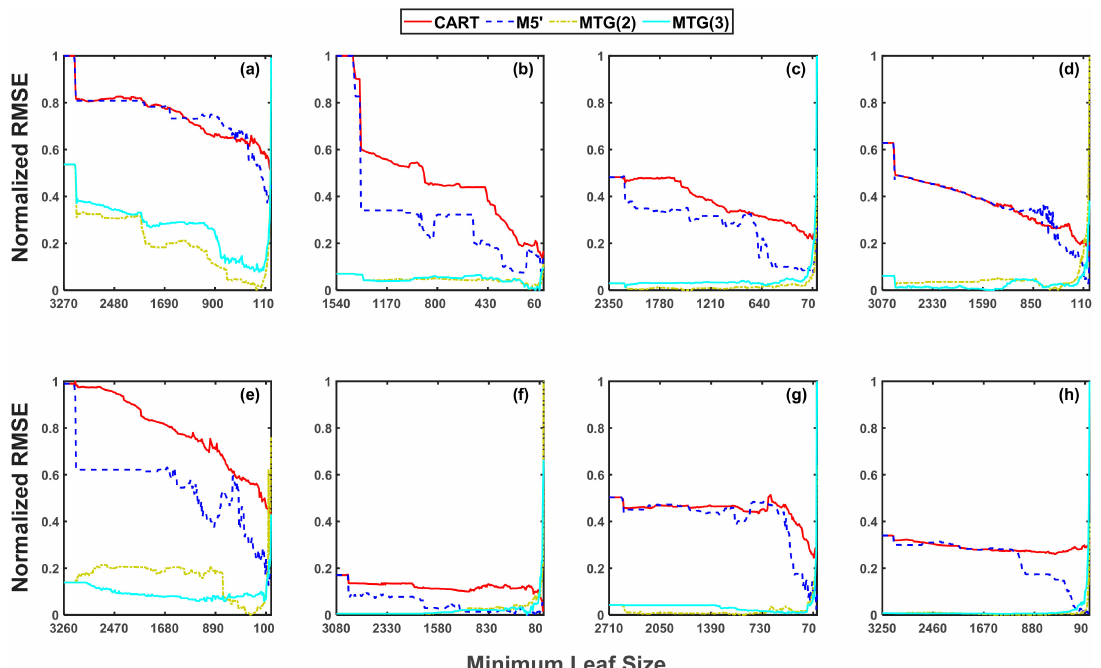
Figure 9. The normalized RMSE values of daily discharge against minimum leaf size in descending order for ( a ) Arkabutla, ( b ) Coralville, ( c ) Dale Hollow, ( d ) Eldorado, ( e ) Folsom, ( f ) Prado, ( g ) Shasta and ( h ) Trinity for CART, M5 (cid:48) , MTG(2), and